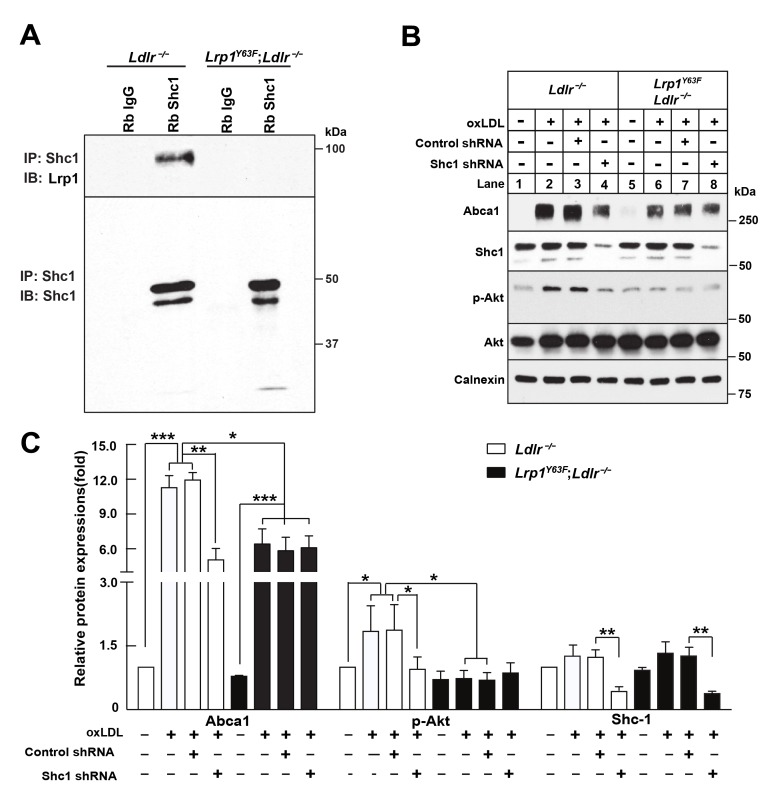
Binding of LRP1 to Shc1 is required for oxLDL-induced Abca1 up-regulation in macrophages.(A) Representative immunoblots probed for LRP1 (upper) and total immunoprecipitated Shc1 levels in input cell lysate (lower) from co-immunoprecipitation assays using antibodies against Shc1 (Rb Shc1) or rabbit IgG (Rb IgG). Macrophages were treated with oxLDL for 24 hr prior to immunoprecipitation. (B) Peritoneal macrophages were infected with lentivirus expressing scramble shRNA or Shc1 shRNA for 48 hr to knockdown endogenous Shc1 expression, followed by oxLDL treatment for an additional 24 hr. Protein expression was determined by quantitative Western blot analysis. from three independent experiments (C). *p<0.05; **p<0.01; ***p<0.001.